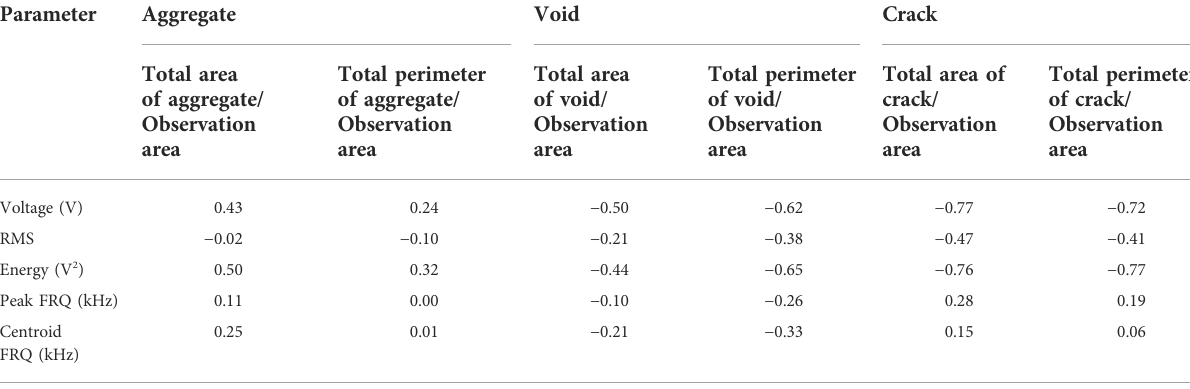
TABLE 7 Correlation between proportions parameters of concrete components and AU